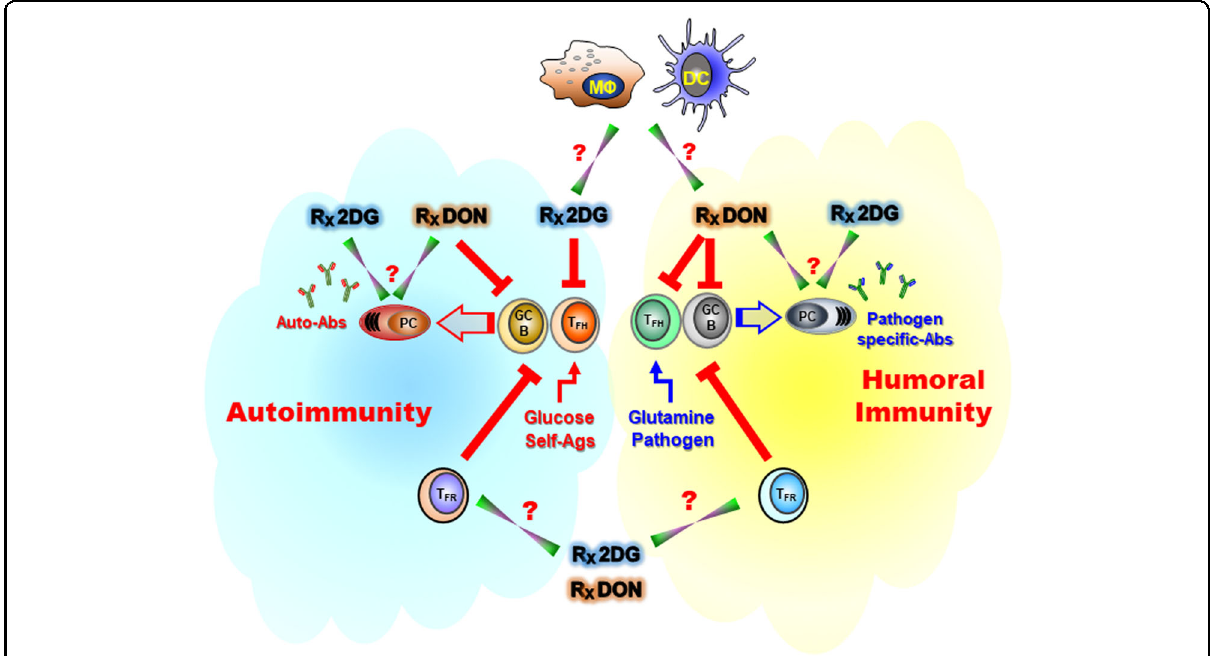
Fig. 3 Proposed model of the requirements of GC B cells and T FH cells for glucose and glutamine in response to autoimmune activation (left) or immunization with a foreign antigen (right). The production of class-switched antibodies, either in response to TD-antigens or autoantigens, requires glutamine and is blocked with DON. In contrast, only the spontaneous differentiation and expansion of T FH cells in lupus- prone mice depends on glucose metabolism. This process and the subsequent GC B-cell expansion and autoantibody production is blocked with 2DG. On the other hand, exogenous Ag or pathogen-driven T FH differentiation and expansion is glucose-independent, and therefore not affected by 2DG. The consequences of inhibiting glycolysis or glutaminolysis have not been examined in T FR cells, PCs, FDCs, and tingible body macrophages. The labels above the cells show the effects of 2DG and DON. Red T lines indicate inhibition and green inverted triangles indicate cellular targets for which the effect has not yet been